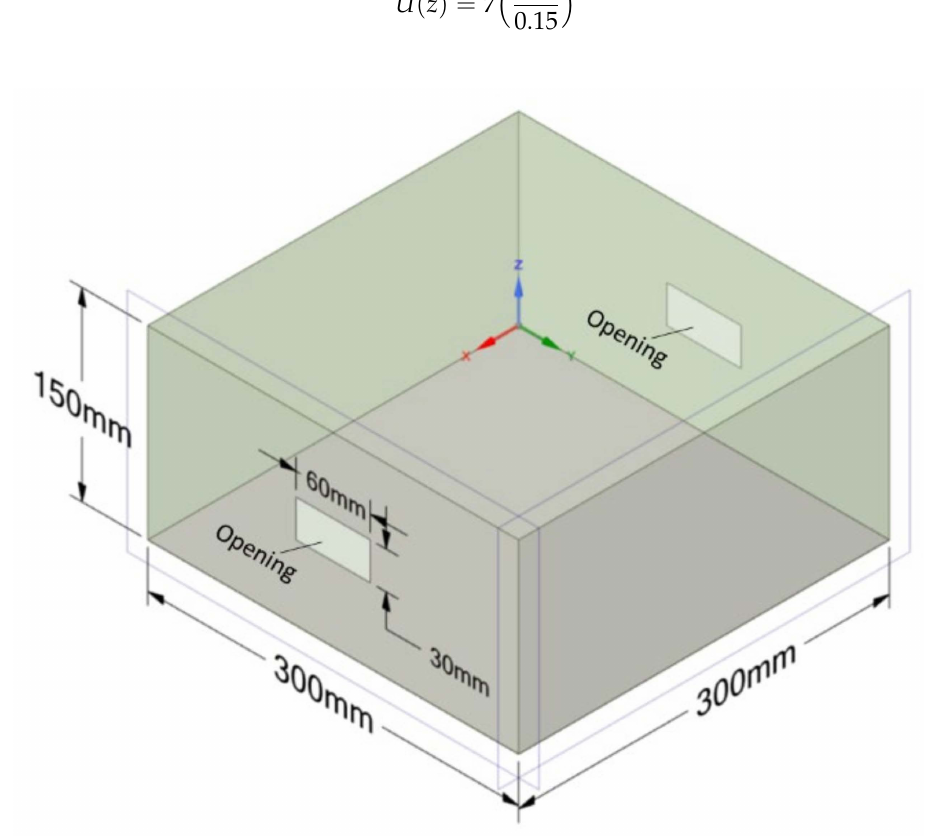
Figure A4. Cross-ventilation model